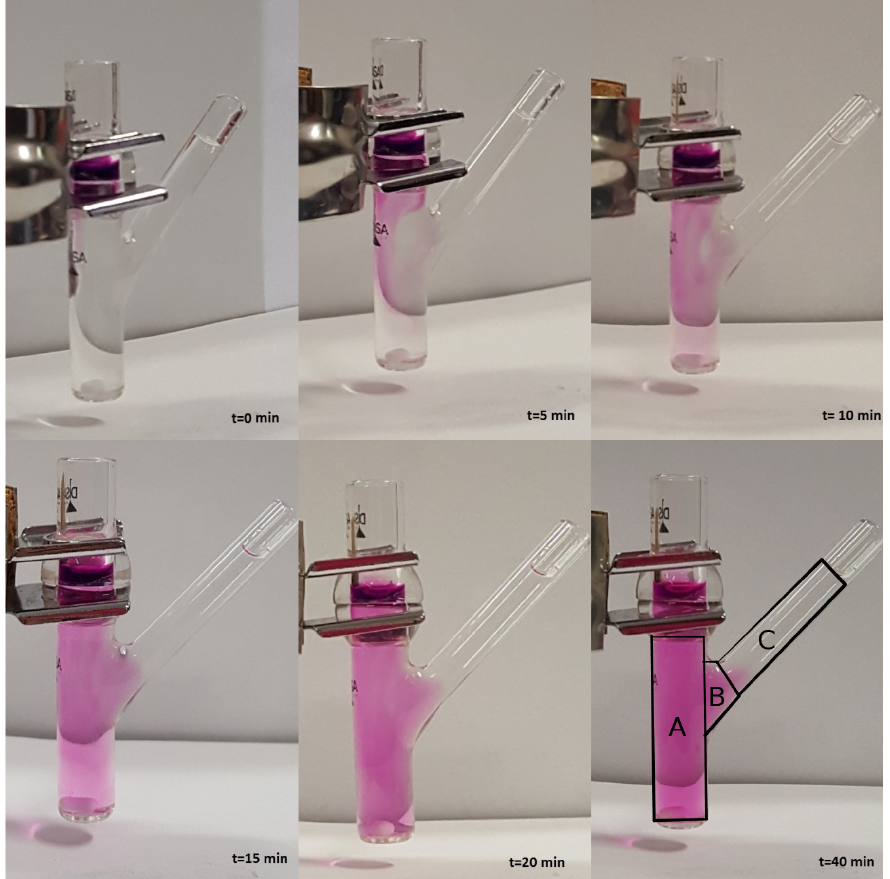
Figure 2. Release experiment in an unjacketed Franz cell at T = 25 ◦ C with a colored marker (KMnO 4 0.1 M in distilled water). Rotational speed: 100